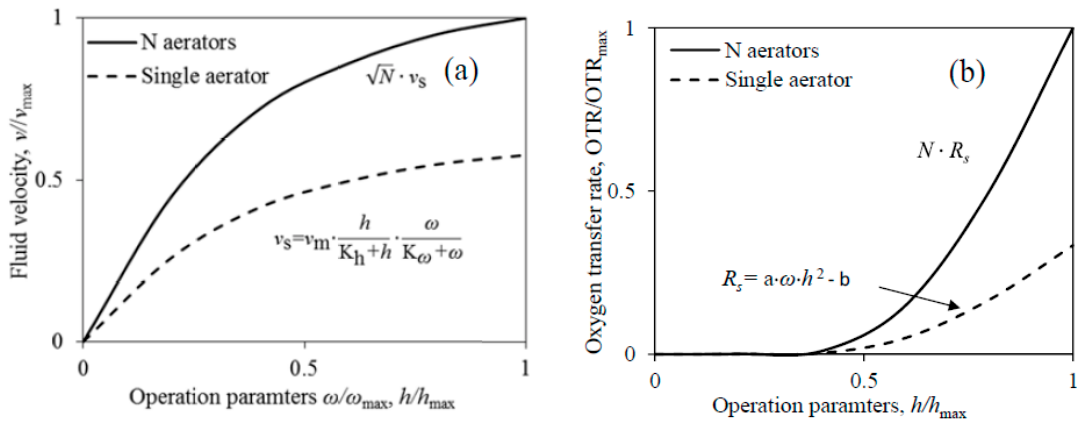
Figure 2. The concept of the multiple surface aerators. ( a ) Model of fluid velocity; ( b ) Model of oxygen transfer rate (OTR). v max and h max are the observed maximal fluid velocity and wet depth for normalization, respectively. N is the number of rotators. v s and v m are the actual and maximal fluid velocity by a single aerator, respectively. R s is the OTR of single aerator. ω is the rotating frequency and h is the wet depth of aerator. K h , K ω , a and b are constants.